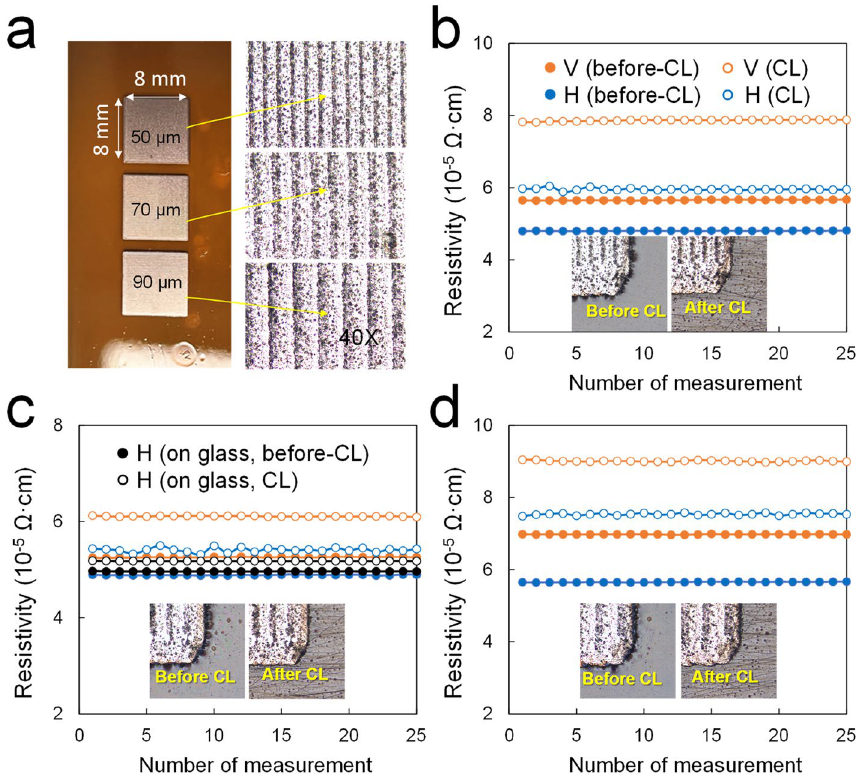
Figure 7. The resistivity of Cu square patterns formed at different scan gaps (50, 70, and 90 μm) and SFL: ( a ) Camera images of Cu square (8 × 8 mm 2 ) patterns on PI and their microscope images, ( b ) resistivity curves of the 50 μm scan gap, ( c ) 70 μm scan gap, and ( d ) 90 μm scan gap. Note that the resistivity graph includes a comparison of the resistivity in the vertical/horizontal direction with respect to the laser scan direction and before/after cleaning for each case.